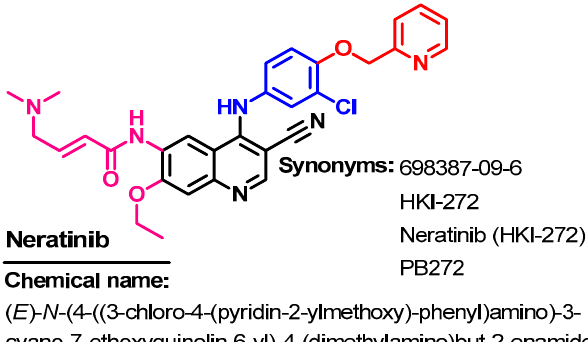
Figure 43. Chemical structure/name/synonyms of neratinib.